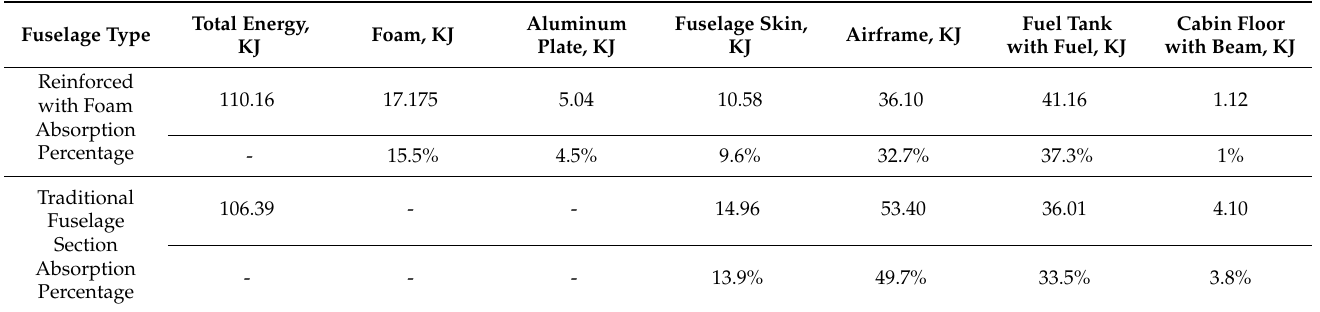
Table 4. Energy absorption by the